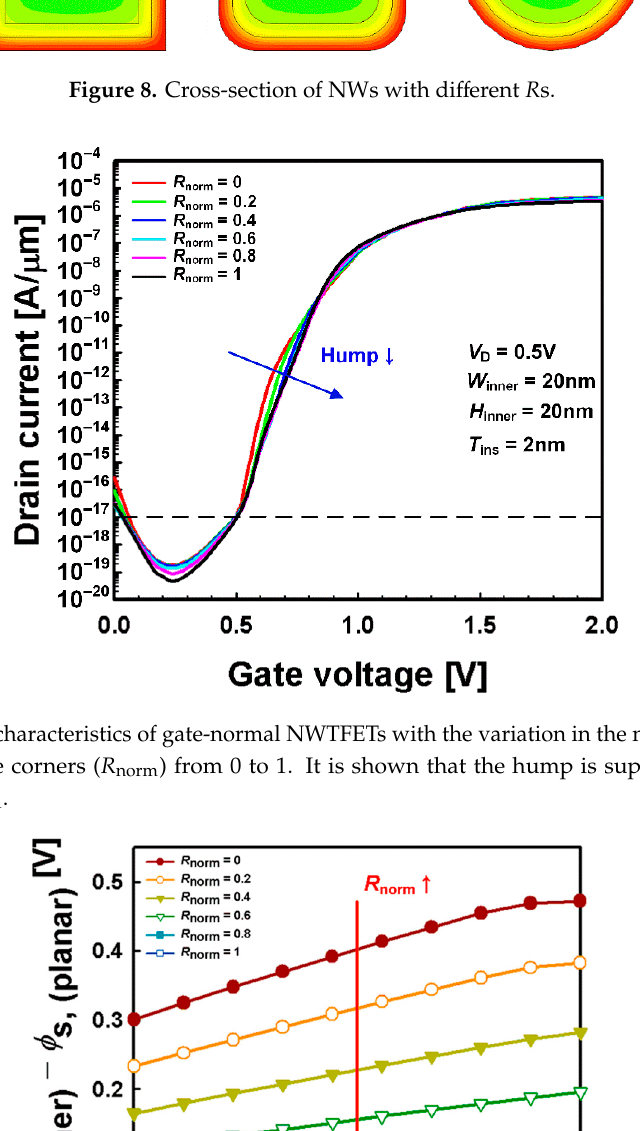
Figure 8. Cross-section of NWs with different R s. Appl. Sci. 2020 , 10 , 8880